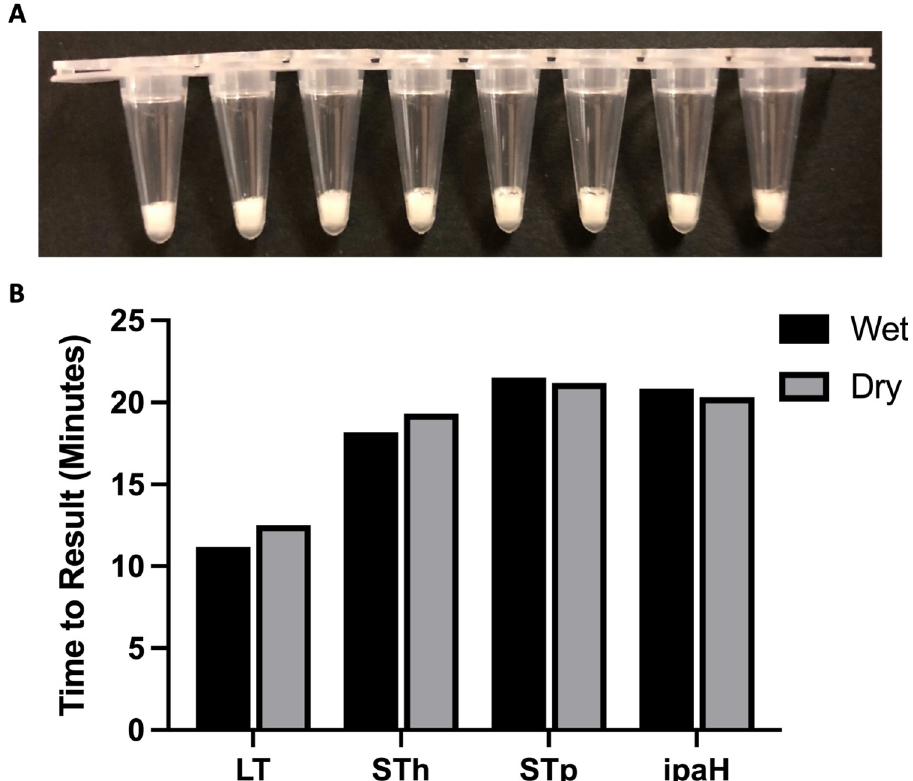
Fig 2. Dry formulation of RLDT LRTs. 2A Appearance of RLDT lyophilized reaction tubes (LRT) strips. 2B Time to result (TTR) for wet and dry formulations of ETEC and Shigella RLDT. LRT strips were tested using RLDT kit before (wet) and after lyophilization (dry). Black: Wet; Gray: